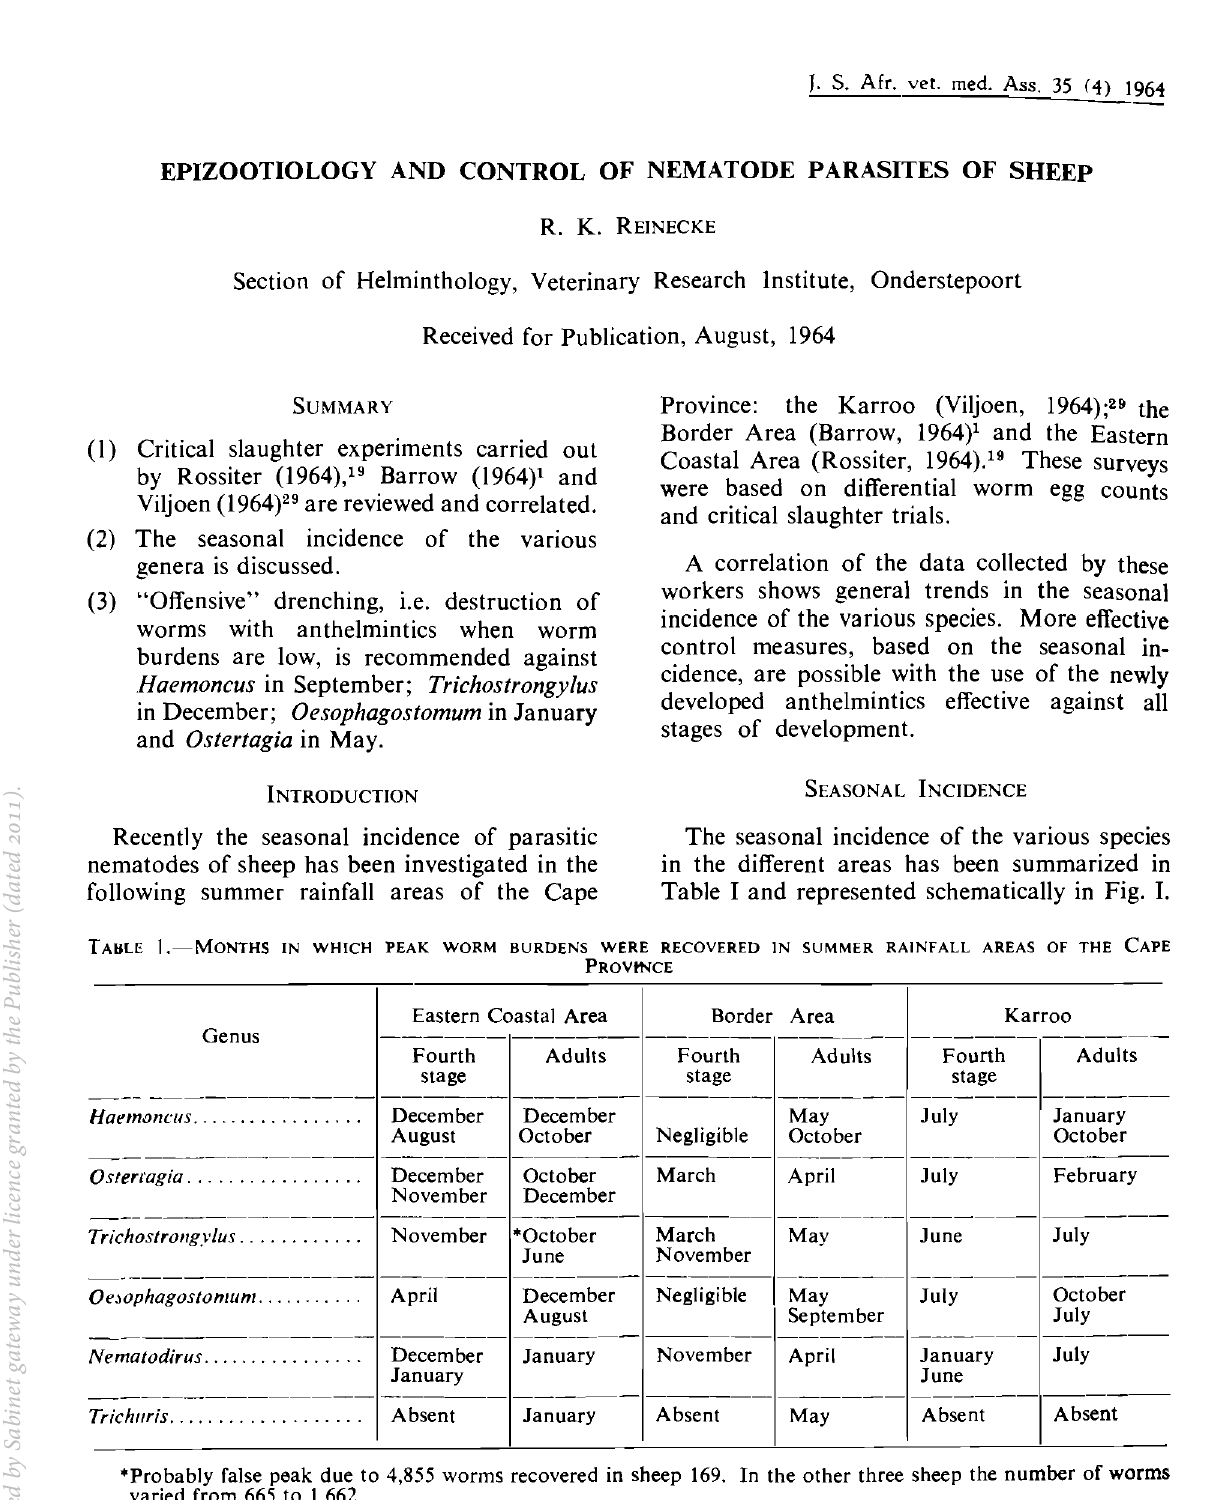
TABLE I.-MoNTHS IN WHICH PEAK WORM BURDENS WERE RECOVERED IN SUMMER RAINFALL AREAS OF THE CAPE